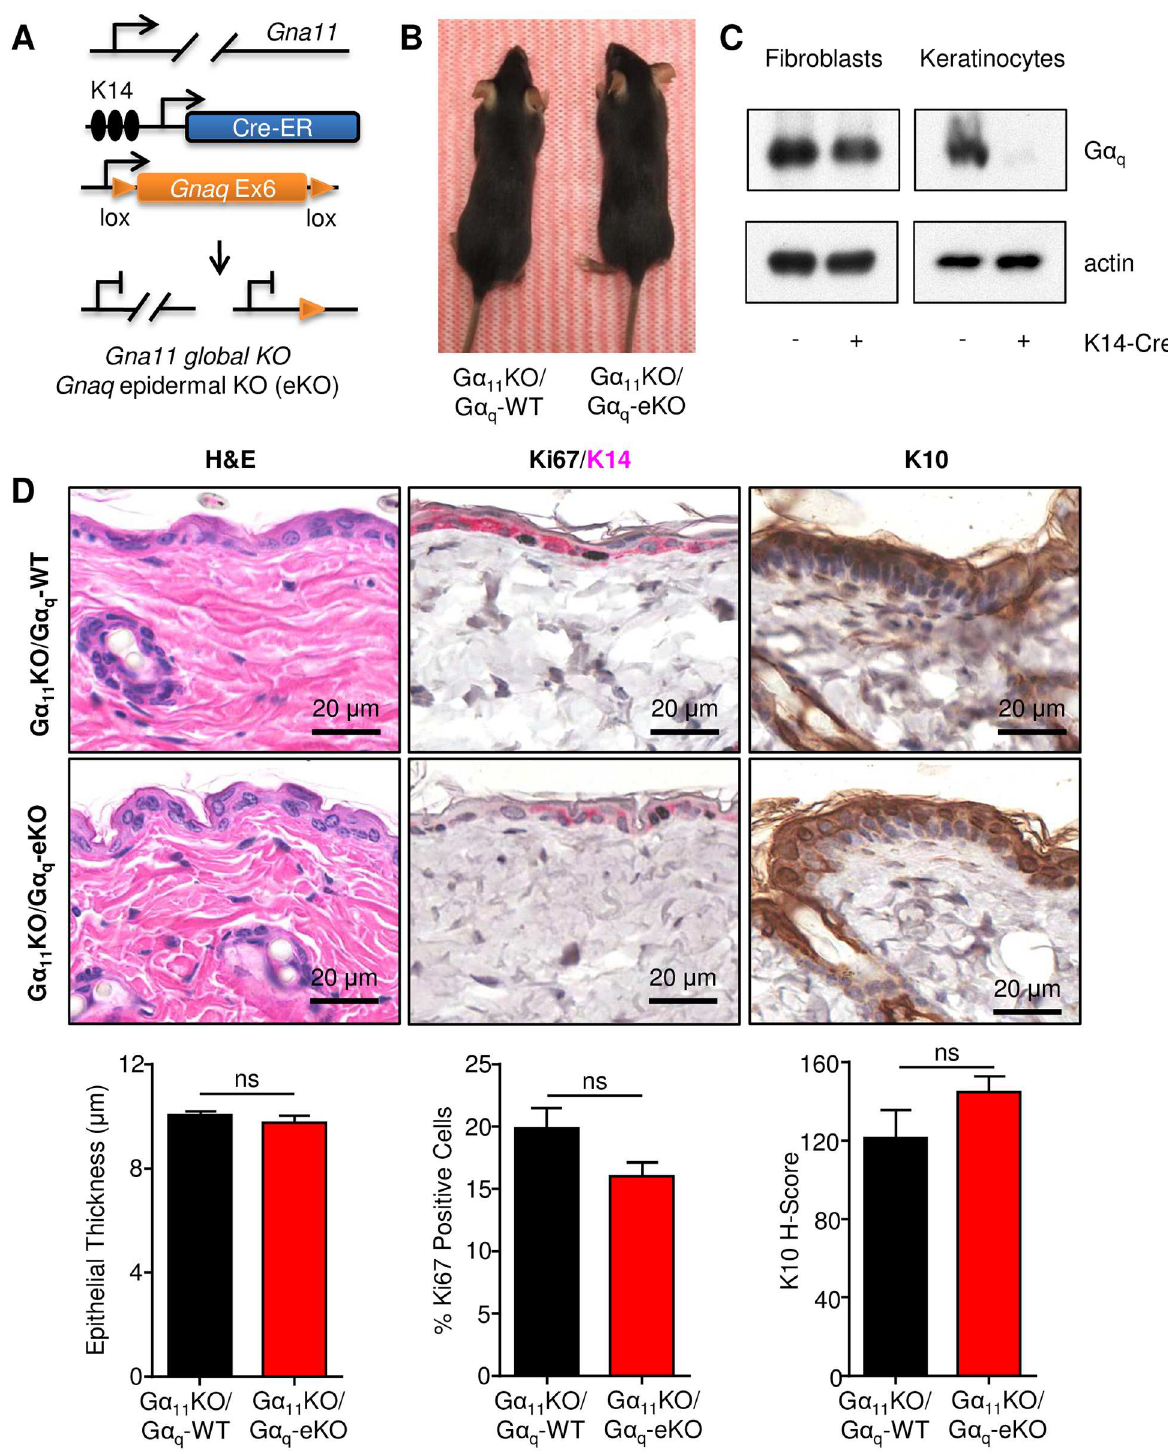
Fig 1. Mice with epidermal loss of G α q do not demonstrate phenotypic defects under normal conditions. A) Schematic representation of the animal model used to derive a delete Gnaq exon 6 (Ex6) from the basal epidermal compartment concomitant with globaldeletionof Gna11 .B) Representative pictures of G α 11 KO/G α q -WT control and G α 11 KO/G α q -eKO mice. C) Western blot demonstrating G α q deletion in the epidermalkeratinocytes but not fibroblasts after expressionof K14-Cre. D) Normal skin samples from G α 11 KO/G α q -WT control and G α 11 KO/G α q -eKO animals(N = 4 each) were examinedfor histology(H&E), proliferation(Ki67), and differentiation (K10).